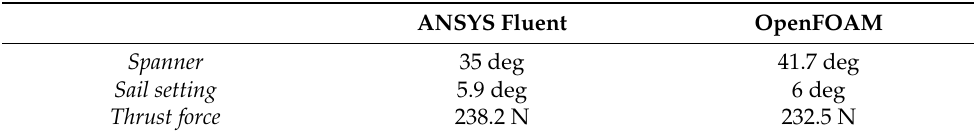
Table 2. Optima rig setting solutions.